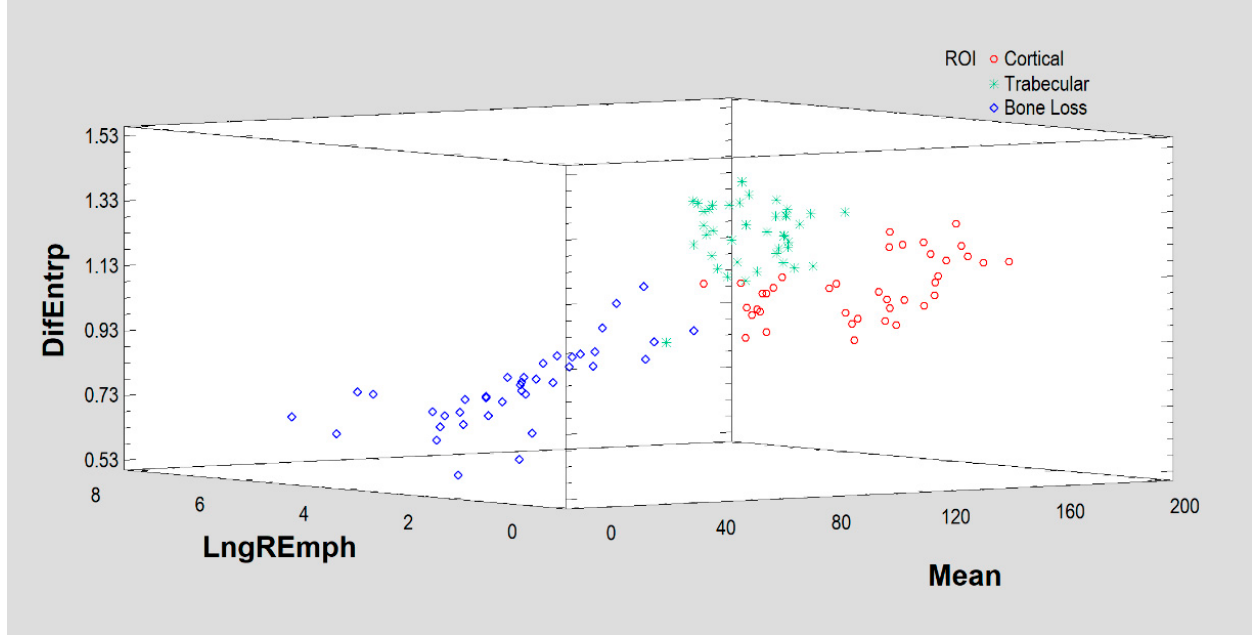
Figure 3. Based on the above three features (DifEntrp, Mean optical density, LngREmph), the algorithm manages to initially separate the results for the three tissues (ROIs), but corticalization (Cortical) is not well discriminated here. It is worth noting that the simple measure of mean optical density itself shows the differences between the regions of interest studied.